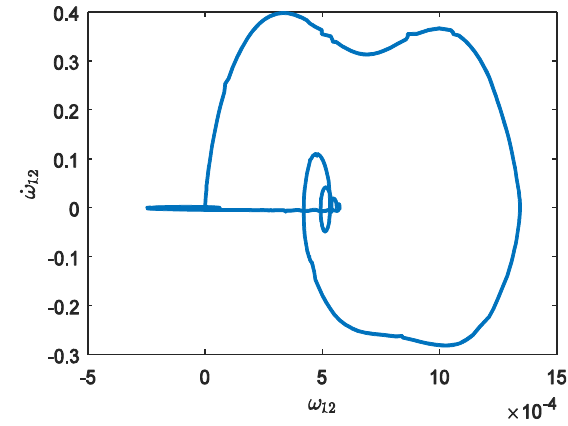
Fig. 6 2D plot of σ and ˙ σ